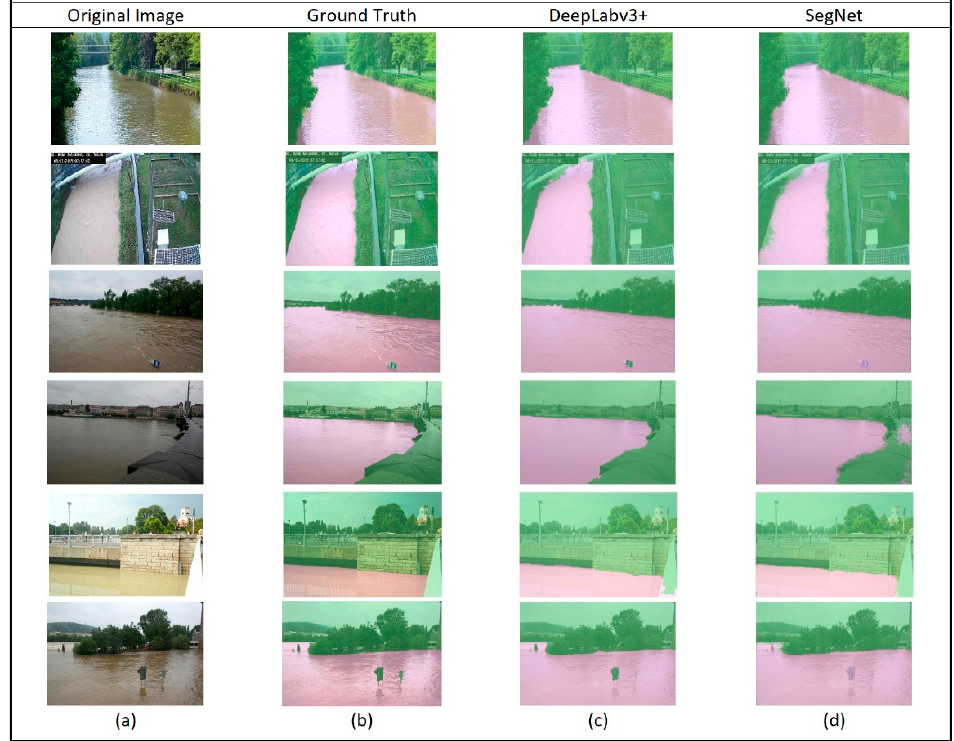
Figure 9. Visualization and comparison of two representative results on test data. ( a ) Original image. ( b ) Ground truth. ( c ) DeepLabv3+ prediction. ( d ) SegNet prediction. Pink and green colored regions represent water and background, respectively.